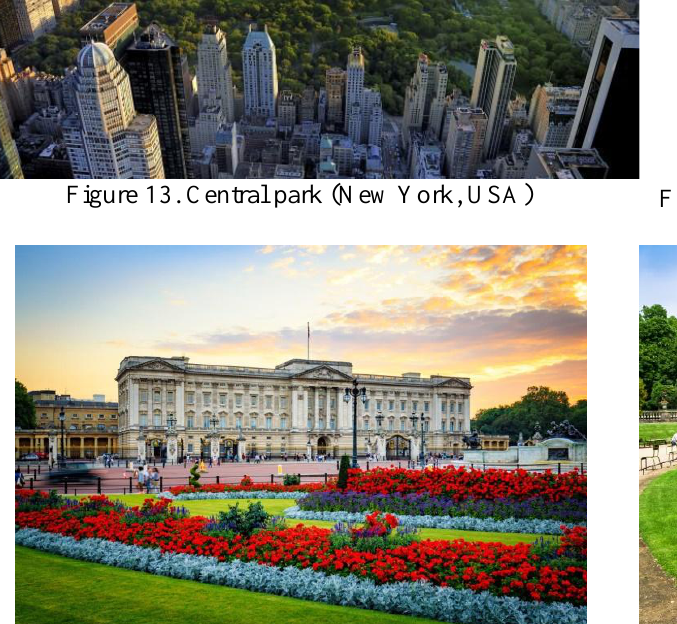
Figure 15. Hyde park (London, Great Britain) Figure 16. Jardin du Luxembourg (Paris,